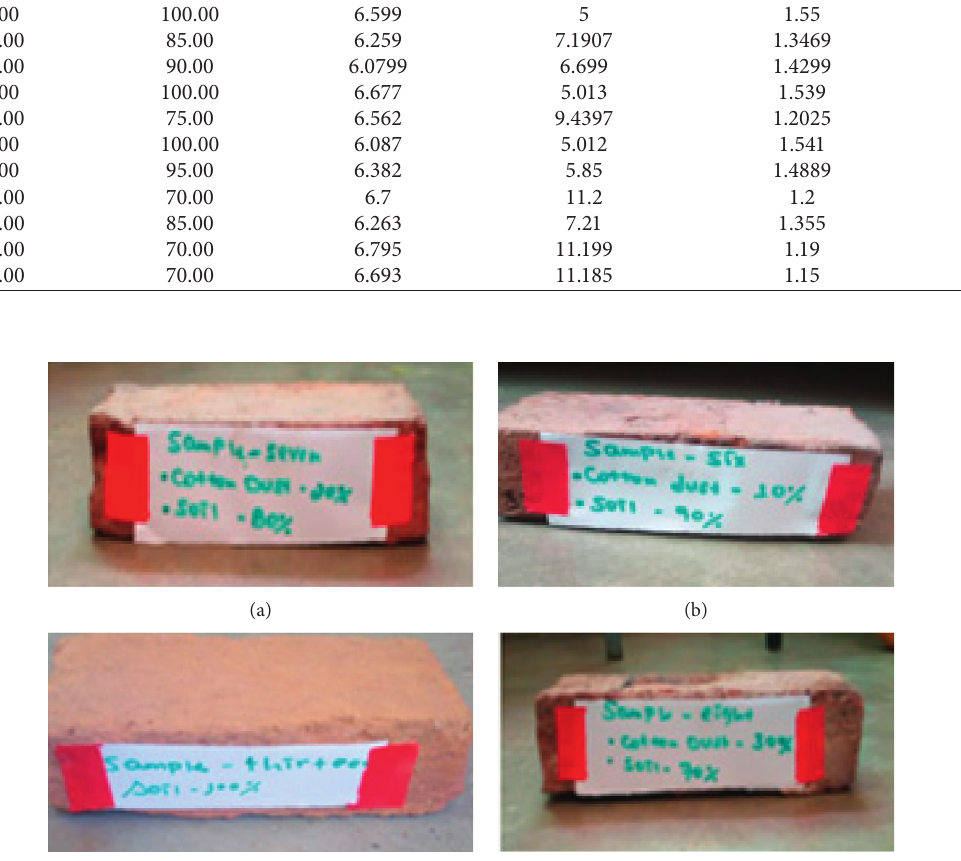
Figure 7: Brick samples manufactured from different mixing ratios. (a) 20% cotton waste and 80% soil; (b) 10% cotton waste and 90% soil;